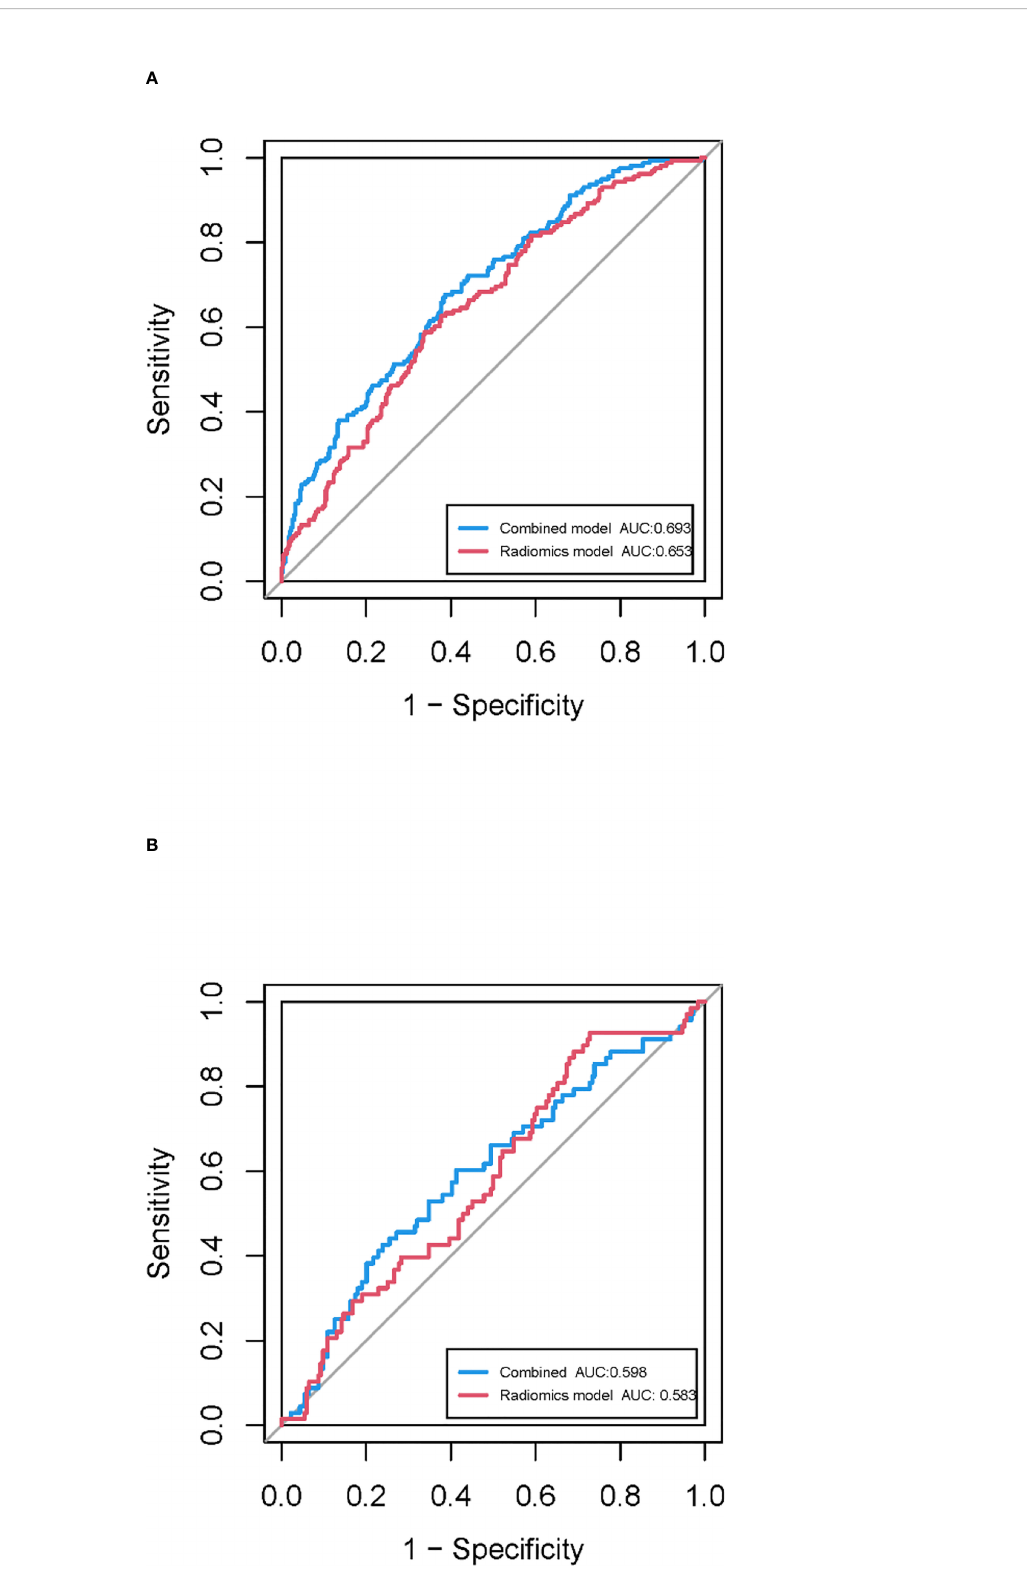
FIGURE 6 ROC curves of the combined model and radiomic model in the training cohort (A) and the test cohort (B)